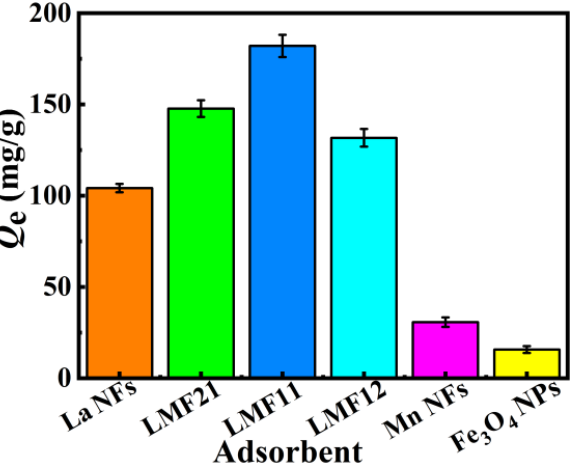
Figure 2. Impact of La/Mn molar ratio on the defluoridation performance of LMF NFs.